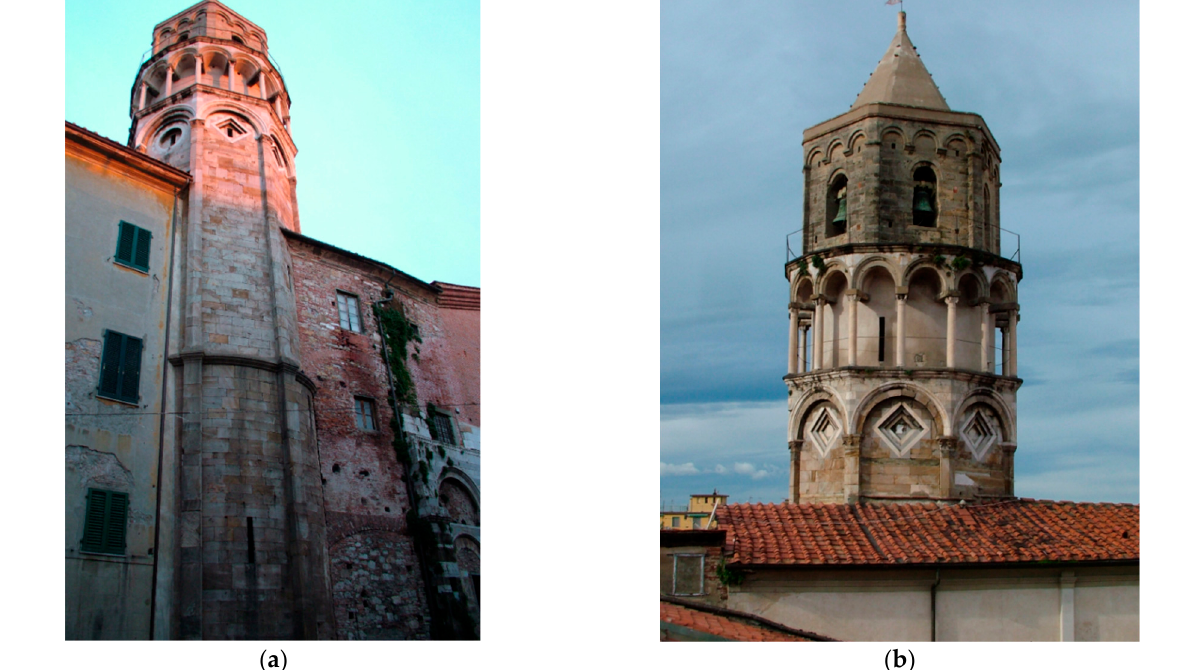
Figure 12. The bell tower of the St. Nicola Church in Pisa: ( a ) the bell tower from St. Maria Street; ( b ) the belfry.